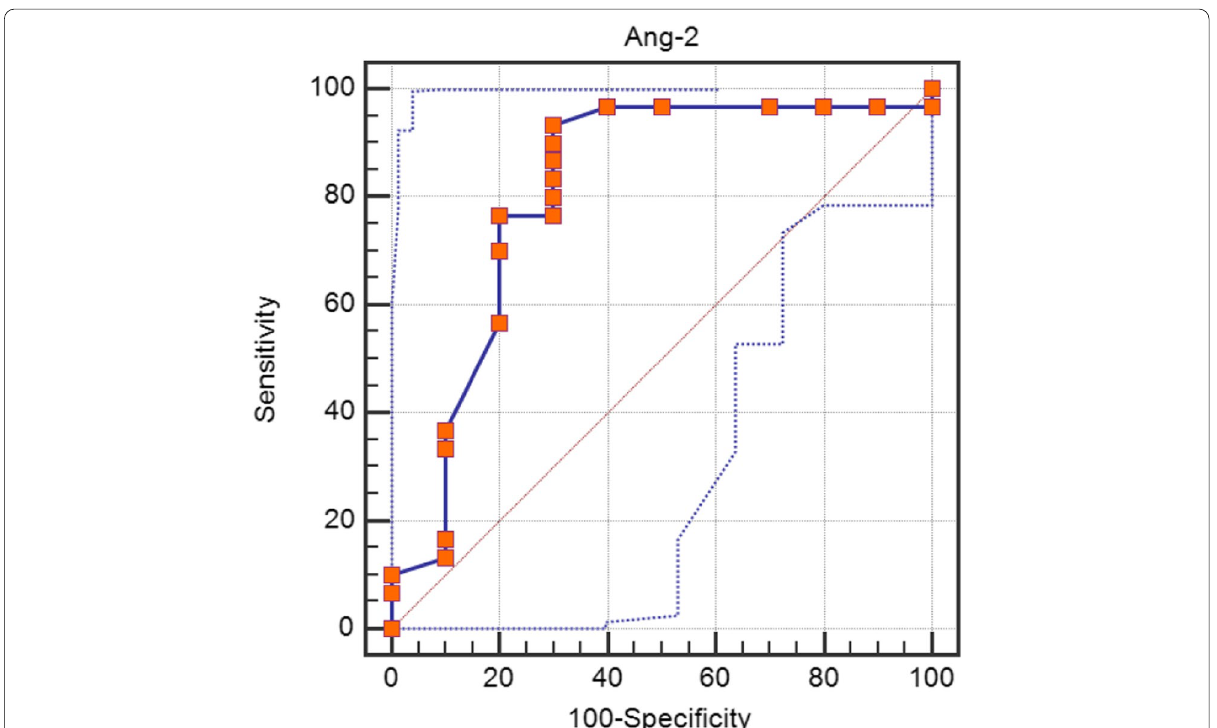
Fig. 2 ROC curve of pretreatment Angiopoietin-2 value in prediction of fibrosis